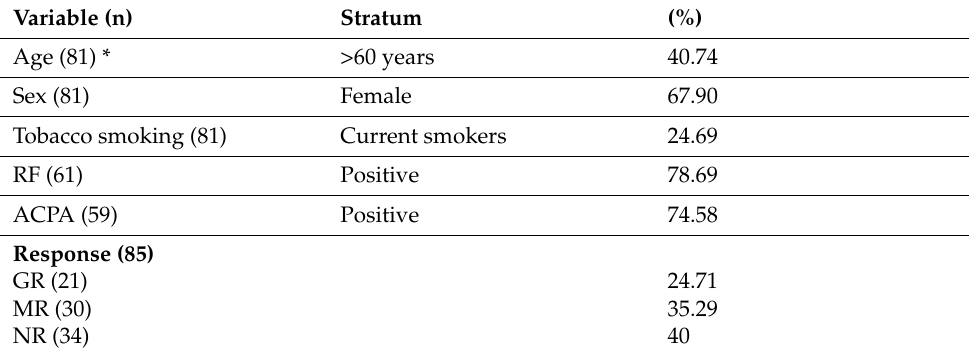
Table 1. Characteristics of the patients included in the study.